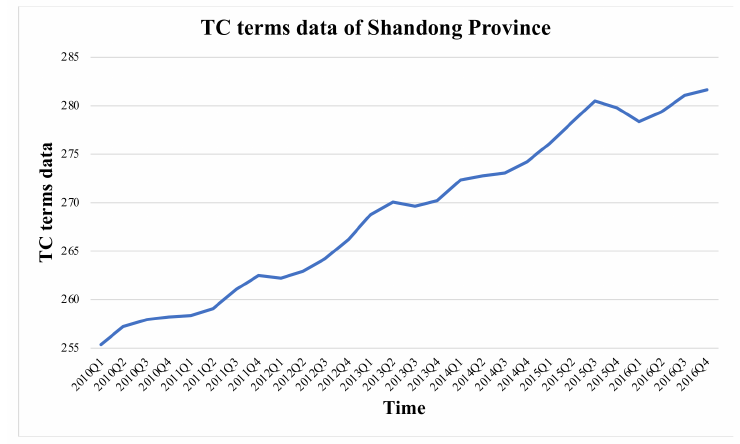
Figure 7. TC terms data of Shandong Province.